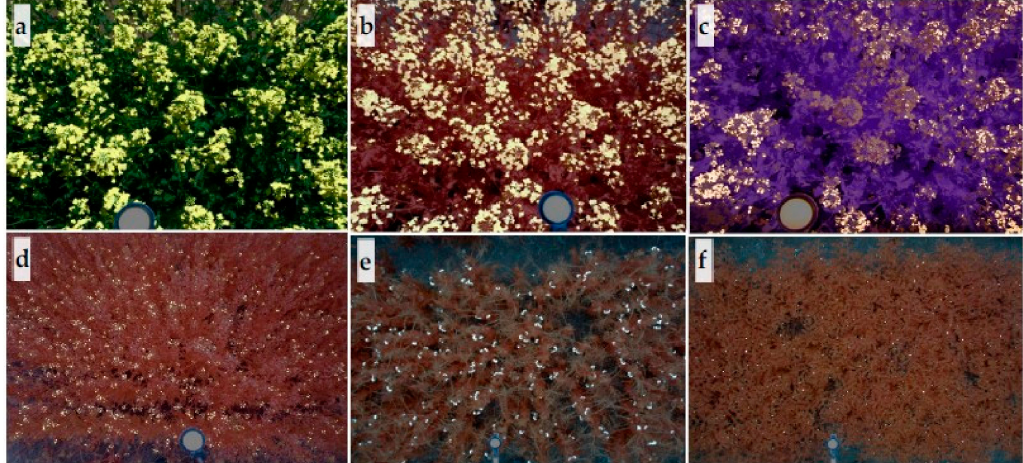
Figure 3. Examples of processed images with flower highlighted. Overlapped flower mask and original images derived from ( a ) C-RGB, ( b ) MS1, and ( c ) MS2 sensors for winter canola, and MS1 sensor image for ( d ) camelina, ( e ) pea, and ( f ) chickpea. Flowers are highlighted by white. Undetected winter canola flowers under shadow can be seen in ( a ) or ( c